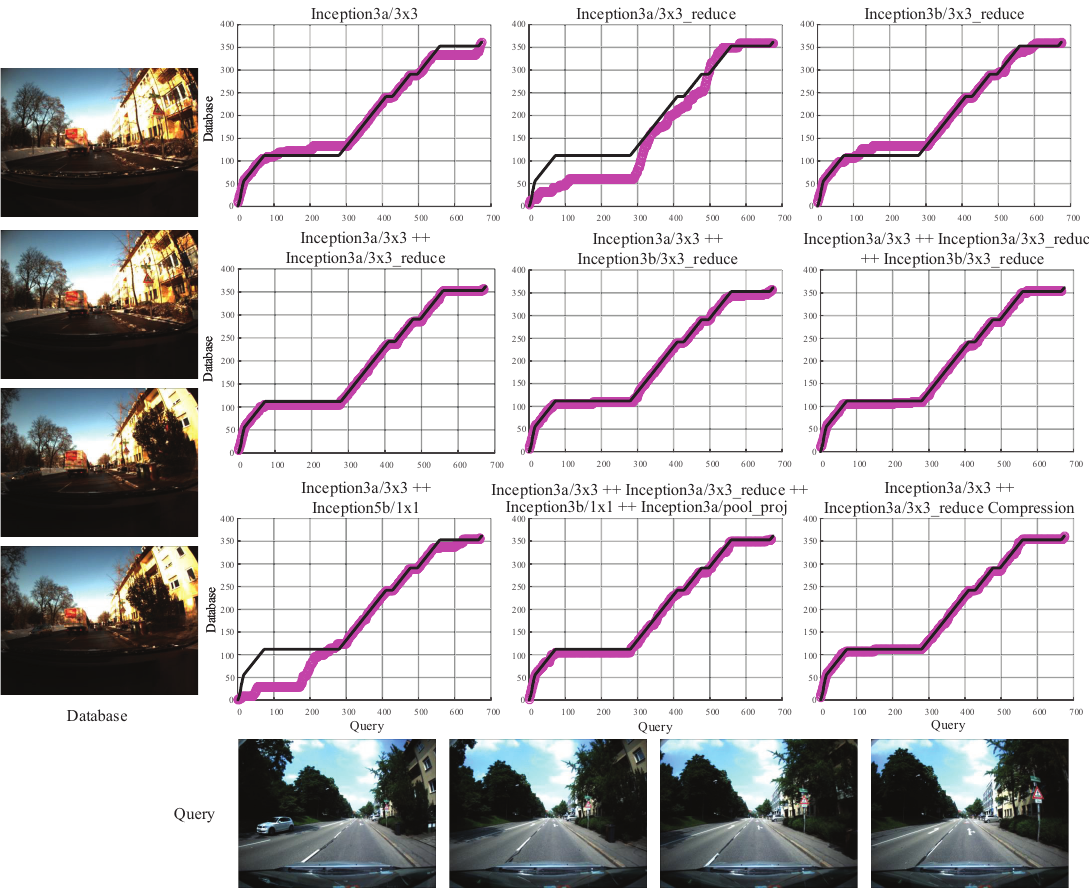
Figure 16. The performance of different layers and different combinations of layers in GoogLeNet on the Freiburg dataset. In detail, the Inception3a/3 × 3 (28 × 28 × 128) is most robust against illumination changes and cross-season changes. The Inception3a/3 × 3_reduce (28 × 28 × 96) and Inception3b/3 × 3_reduce (28 × 28 × 128) are second best layer for illumination invariance and cross-season invariance, respectively. The Inception5b/1 × 1 (7 × 7 × 384) and Inception3a/pool_proj (28 × 28 × 32) are best and second best layer for viewpoint invariance, respectively. The black line denotes the ground truth matches, and the mulberry line denotes the matching results predicted by Visual Localizer.